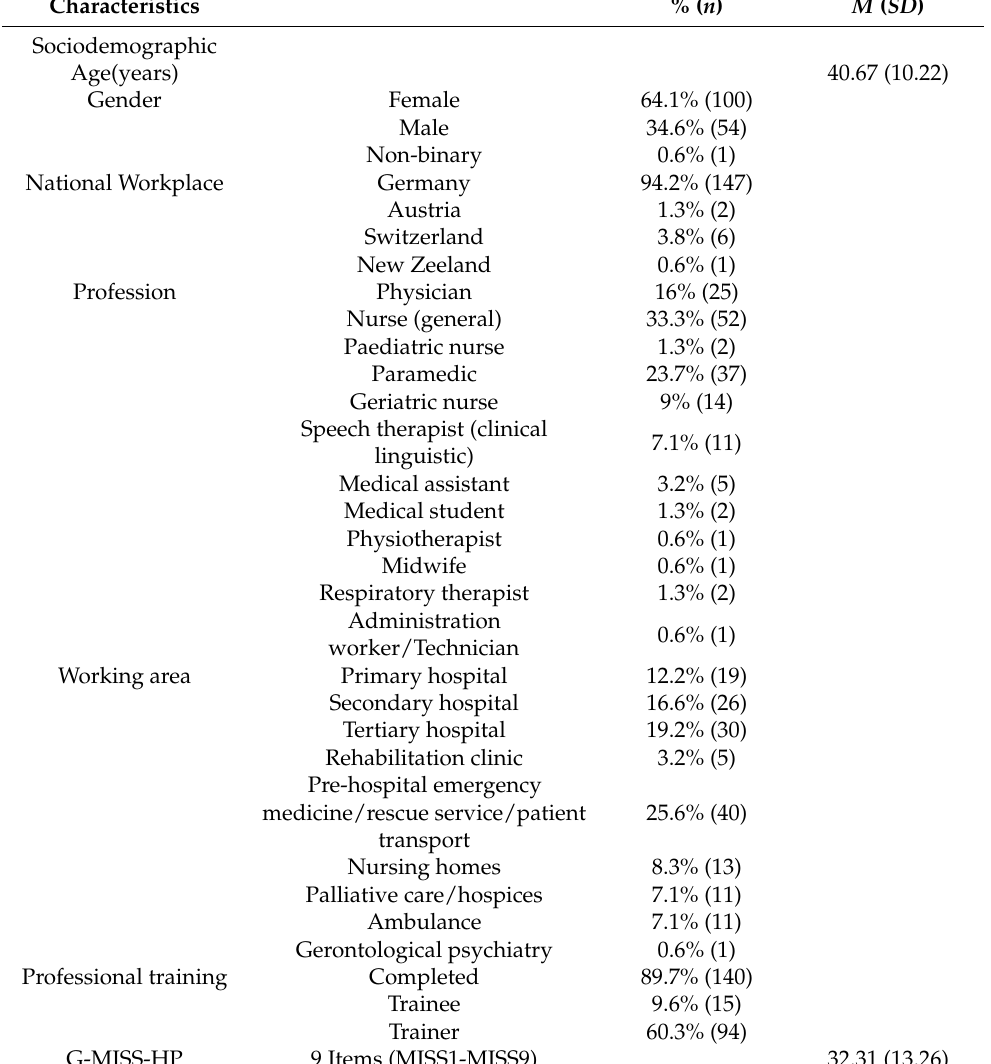
Table 1. Sample characteristics and descriptive statistics of the G-MISS-HP variables and G-SVESTR